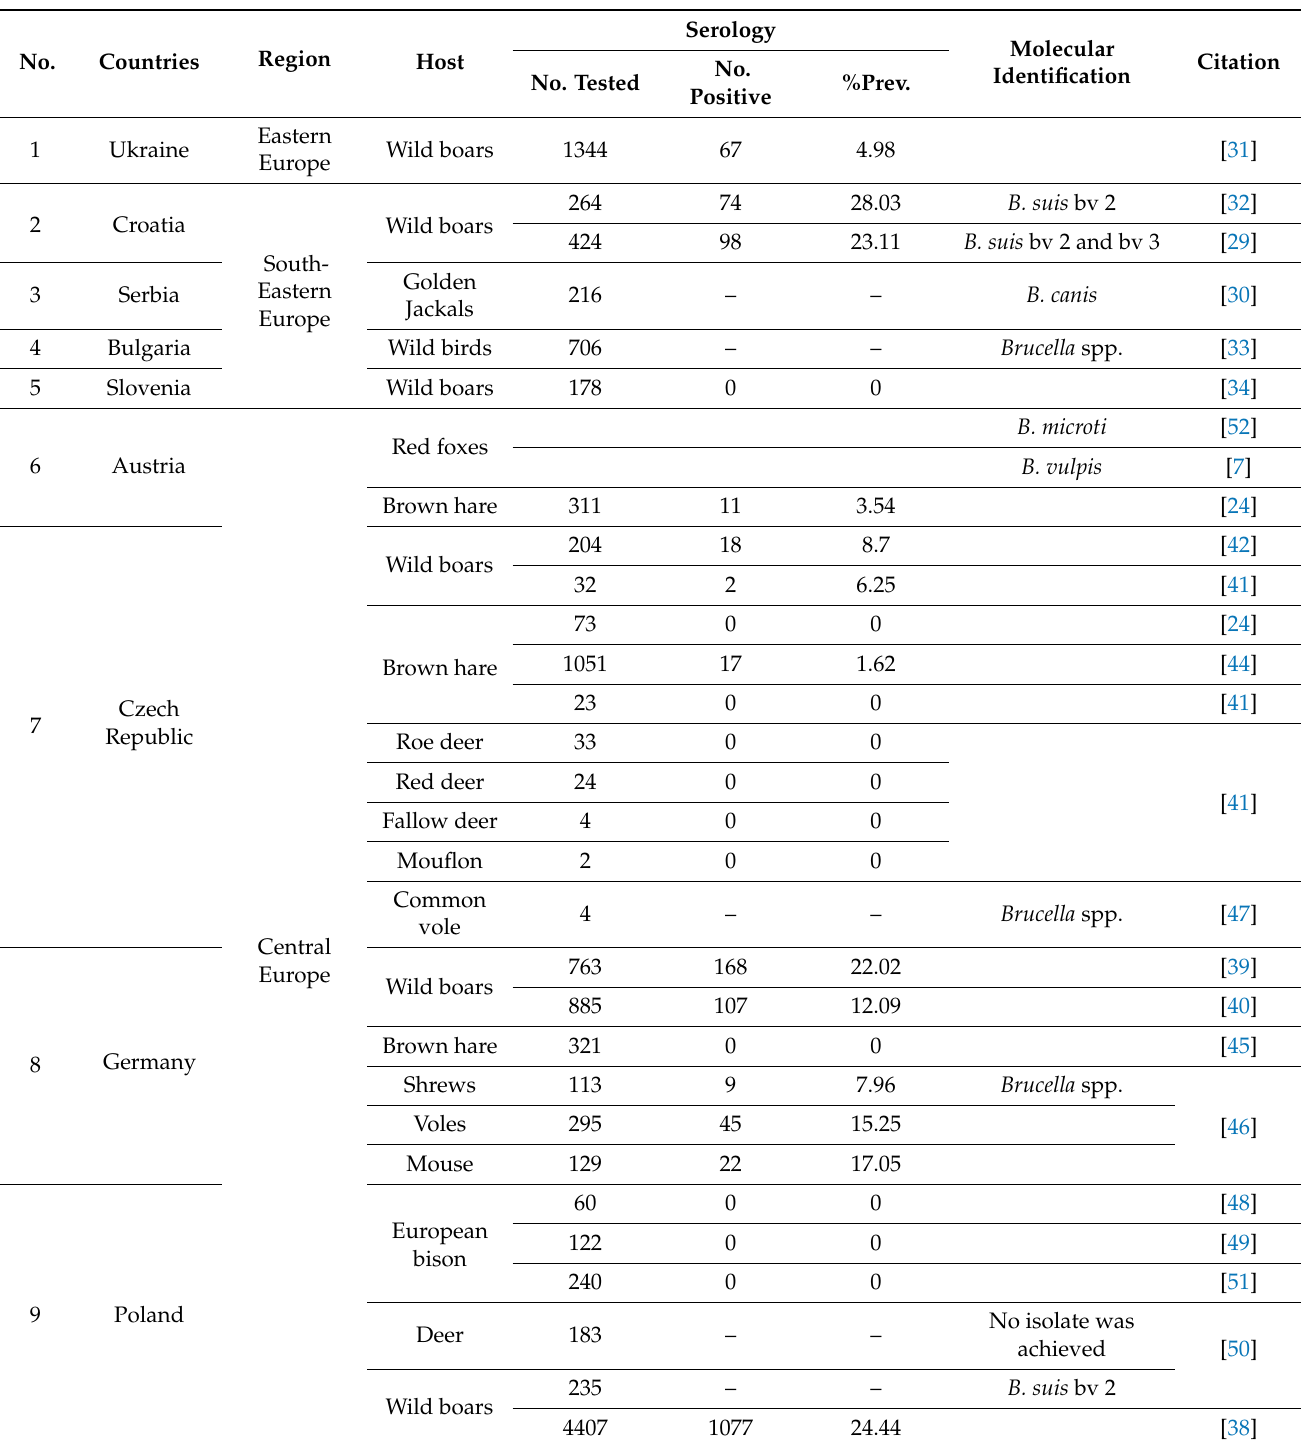
Table 1. Brucellosis in European terrestrial